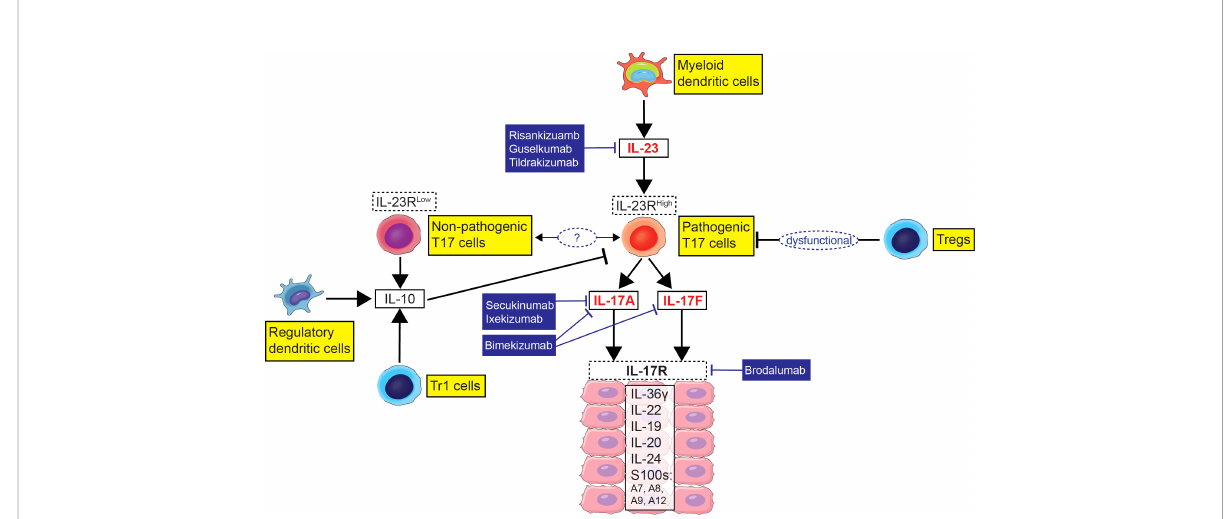
FIGURE 1 Immune model of the imbalance between Type 17 T-cells (T17 cells) and regulatory immune cell subsets in psoriasis with biologic agents targeting the IL-23/T17 cell